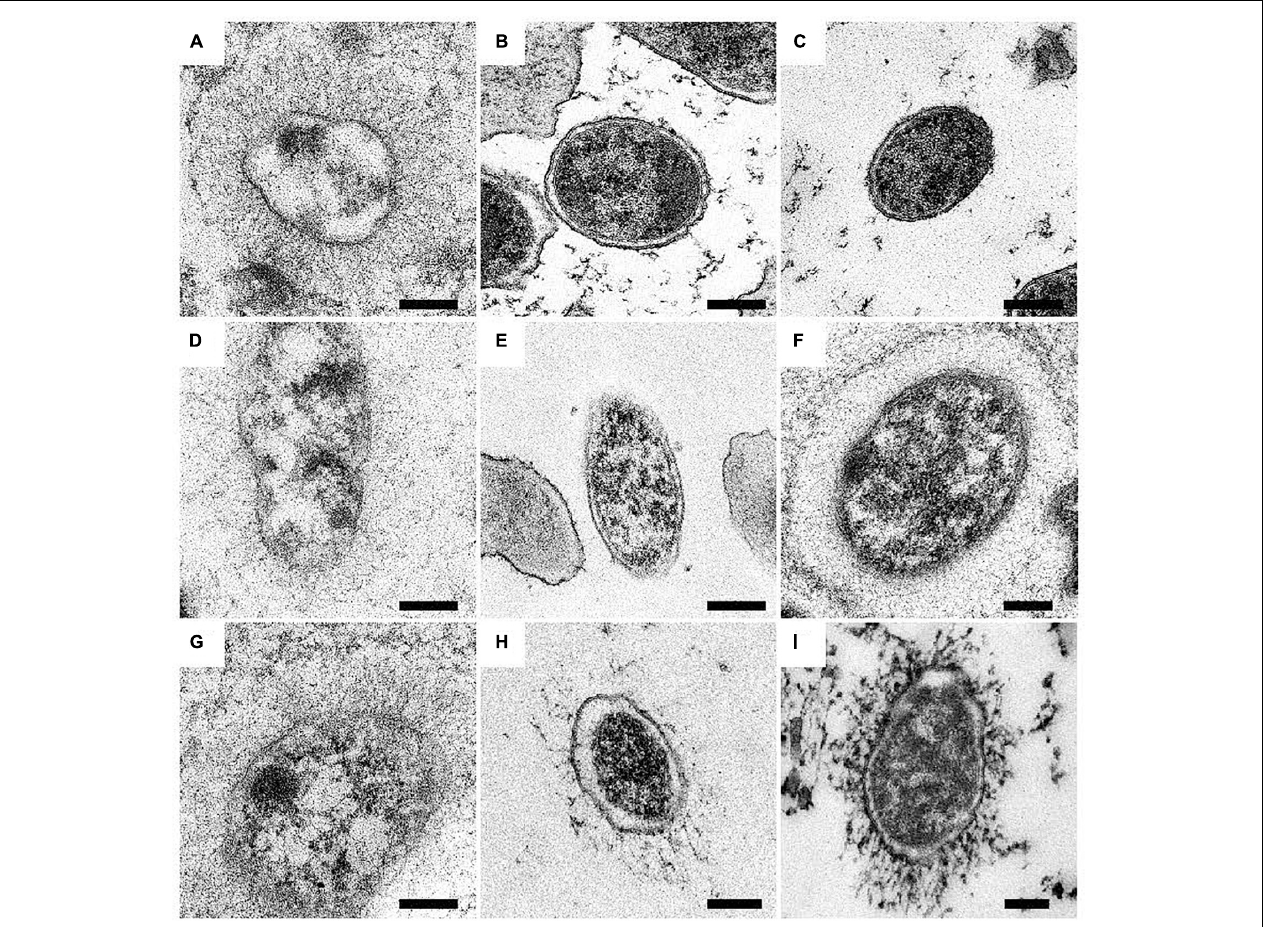
FIGURE 5 | Surface expression of BadA in various B. henselae strains (transmission electron microscopy). Representative images of B. henselae (A) Marseille, (B) Marseille (cid:49) BadA-T, (C) ATCC49882 T var-1, (D) ATCC49882 T var-2, (E) Berlin-I, (F) G-5436, (G) 88-64 Oklahoma, (H) FR96/BK38, and (I) FR96/BK3 are visualised with TEM. Around 30-50 TEM images of bacterial cells per strain were analysed for determination of the phenotype. Expression of BadA is observed for strains Marseille, ATCC49882 T var-2, G-5436, 88-64 Oklahoma, FR96/BK38, and FR96/BK3 but not for strains ATCC49882 T var-1 and Berlin-I, nor for the negative control strain Marseille (cid:49) BadA-T. For technical reasons, samples were prepared by both PLT in DMF and K4M embedding (e.g., Marseille, ATCC49882 T var-2, G-5436, and 88-64 Oklahoma), and HPF/FS and Epon embedding (e.g., Marseille (cid:49) BadA-T, ATCC49882 T var-1, Berlin-I, FR96/BK38, and FR96/BK3). Scale bar: 200